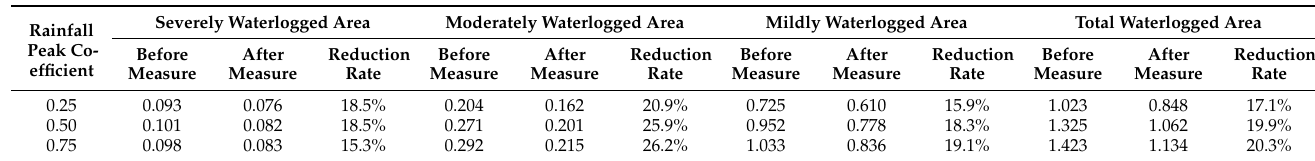
Table 10. Statistical analysis on the waterlogged area reduction effect under different rainfall peak coefficient (km 2 ).